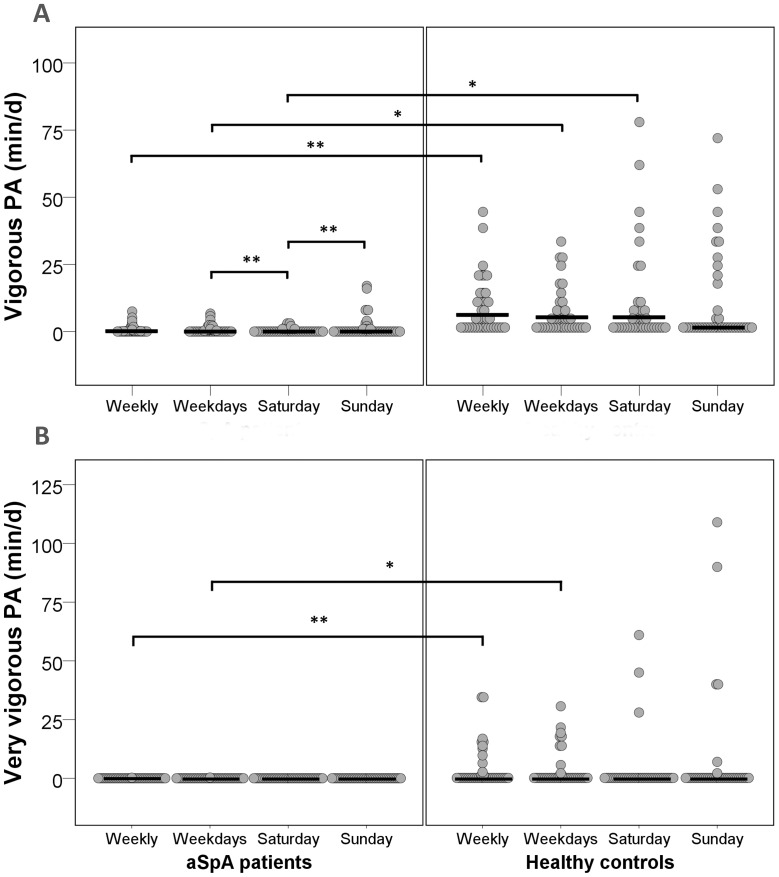
Vigorous (A) and very vigorous (B) physical activities (PA) expressed in min/d for patients with axial spondyloarthritis (aSpA, n = 40) and matched healthy controls (n = 40). Horizontal lines represent median values for weekly average and time point estimates; *p<0.05, **p<0.01.